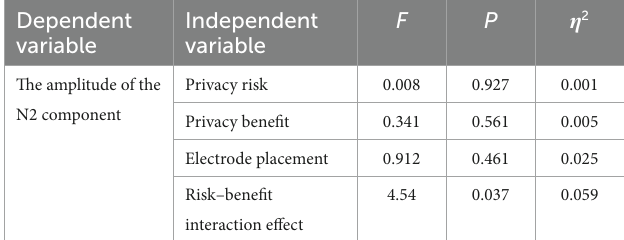
TABLE 3 ANOVA results for P2 component. TABLE 4 ANOVA results for N2